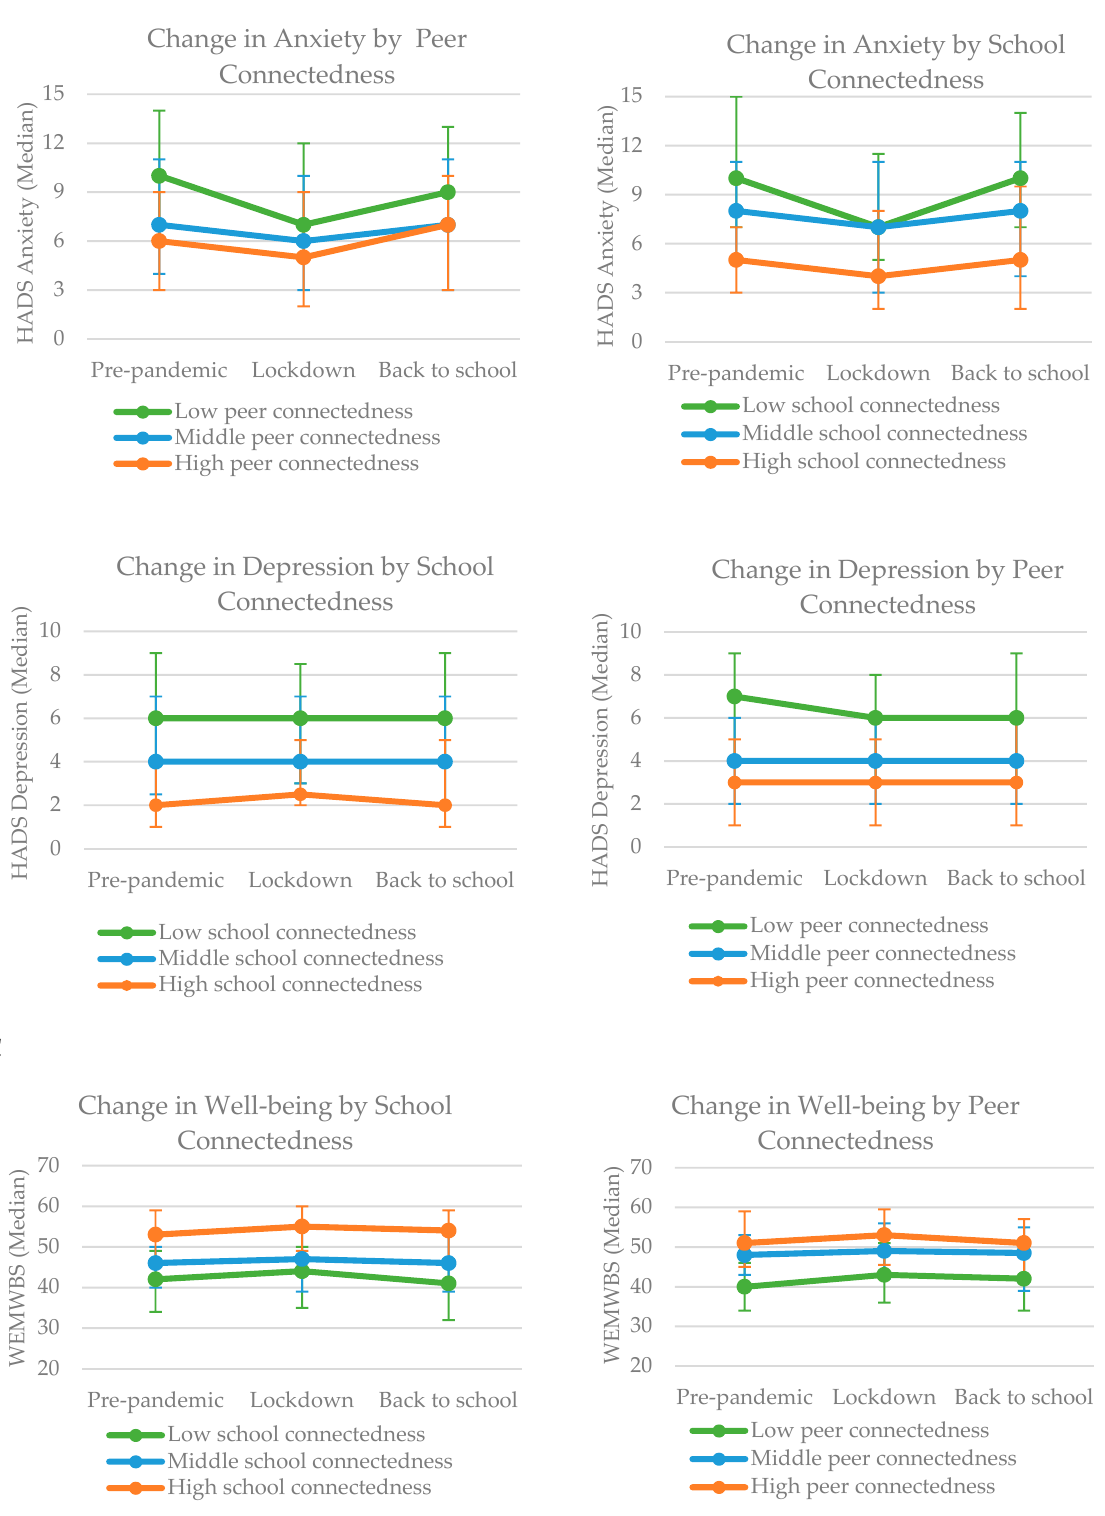
Figure 1. Change in mental health and well-being outcomes over time by levels of school and peer connectedness. ( A ) Change in Anxiety (HADS) over time by levels of school and peer connectedness. ( B ) Change in Depression (HADS) over time by levels of school and peer connectedness. ( C ) Change in Well-being (WEMWBS) over time by levels of school and peer connectedness.